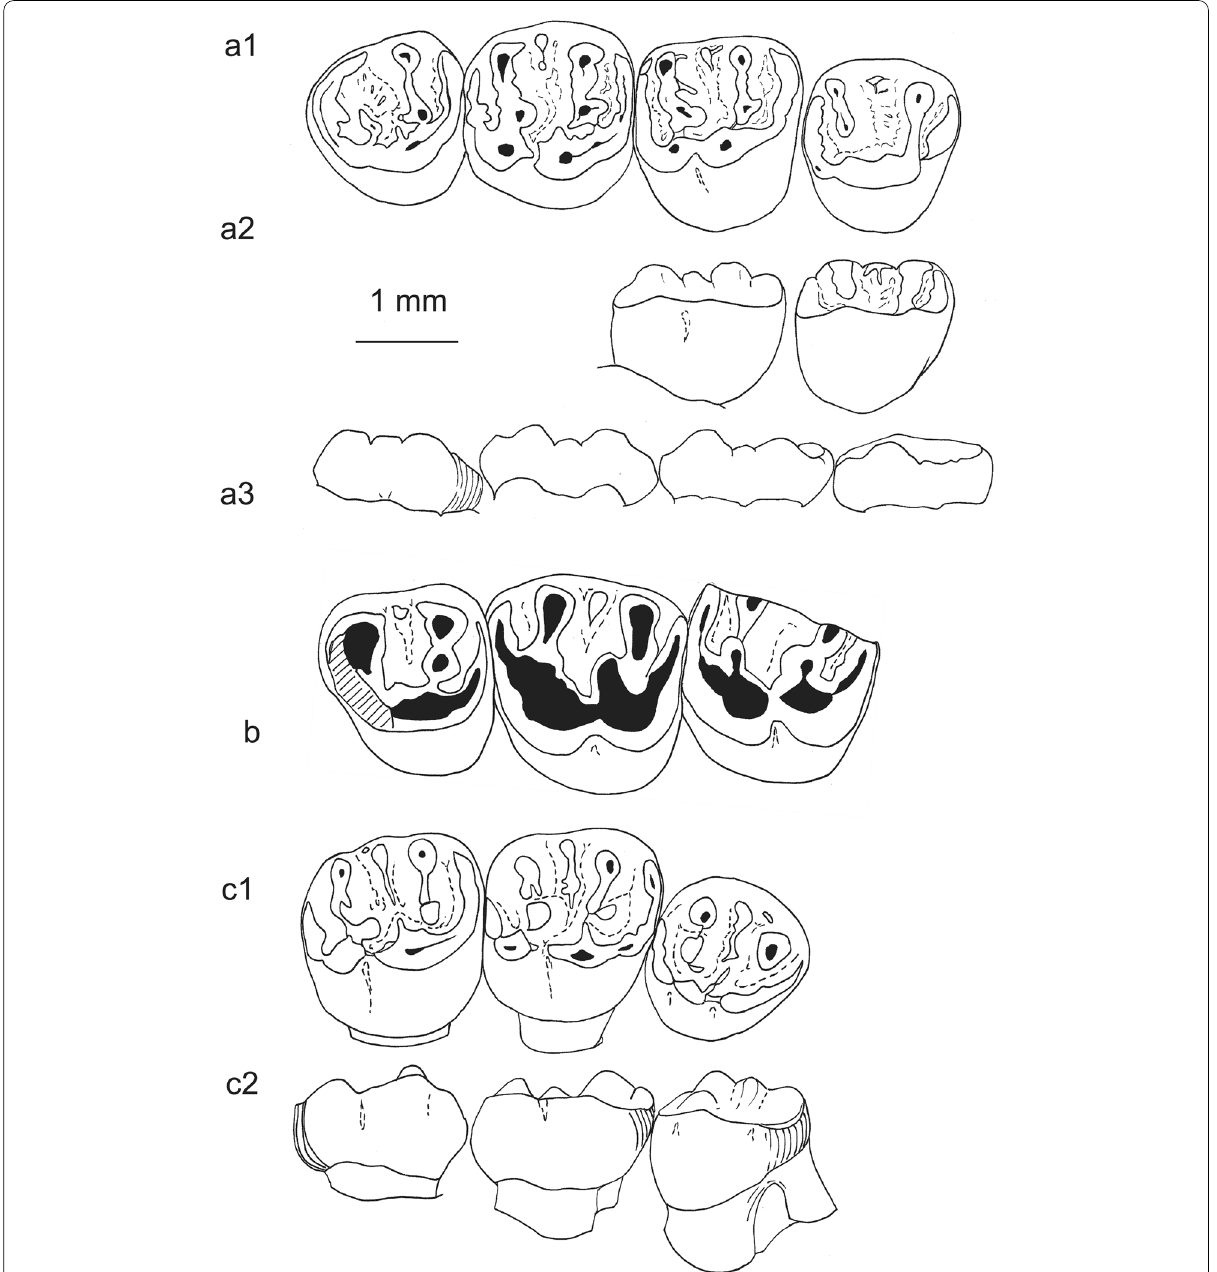
Fig. 6 Upper teeth of Protadelomys cartieri (Stehlin & Schaub, 1951), from Egerkingen (Swiss Jura). a Ek H005, right upper tooth row, P4–M1–3; a1, occlusal view; a2, lingual aspect of M1–P4; a3, buccal aspect of P4–M1–3. b Eg 601, left upper tooth row, P4–M2, occlusal view. c : Ek H006, right upper tooth row, P4–M2; occlusal view, teeth worn. Scale bar: 1